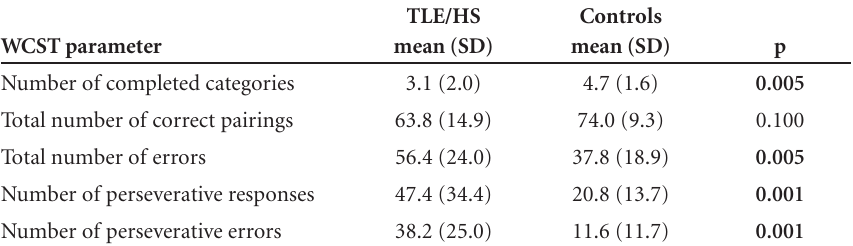
Table 2. Performance on the WCST by patients with TLE/HS, and by